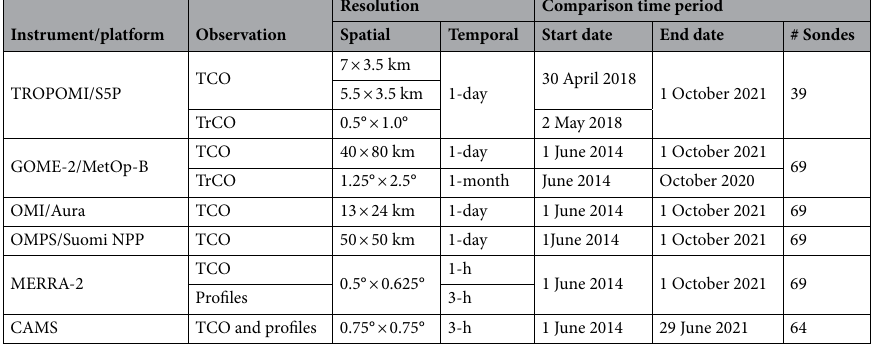
Resolution Comparison time